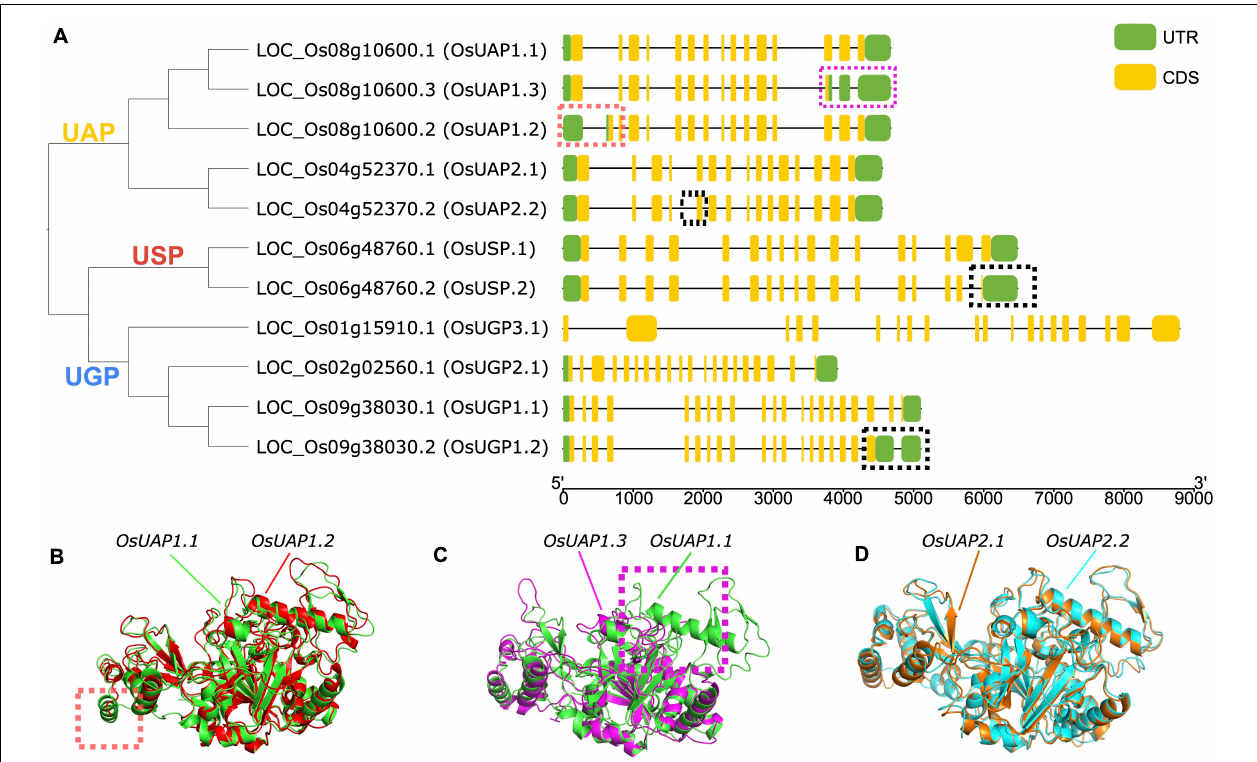
FIGURE 7 | Alternative splicing of UDP glucose pyrophosphorylases (UDPGPs) in Oryza sativa . (A) Gene structure and phylogenetic tree of UDPGP genes in O. sativa , different alternative splicing events were marked with red (OsUAP1.2), purple (OsUAP1.3), or black dashed rectangles. (B) Comparison of the 3D protein structure of OsUAP1.1 (green) and OsUAP1.2 (red). (C) Comparison of the 3D protein structure of OsUAP1.1 (green) and OsUAP1.3 (purple). (D) Comparison of the 3D protein structure of OsUAP2.1 (orange) and OsUAP2.2